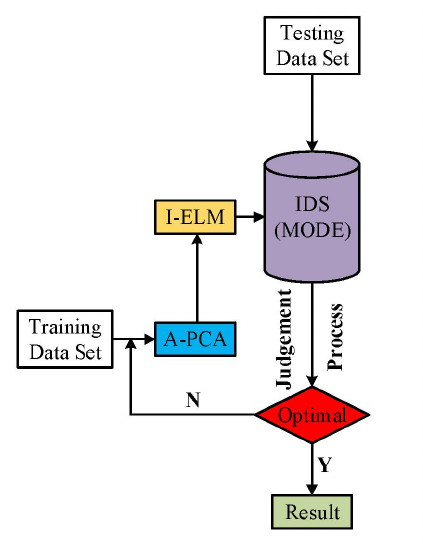
Figure 2. The network detection process of